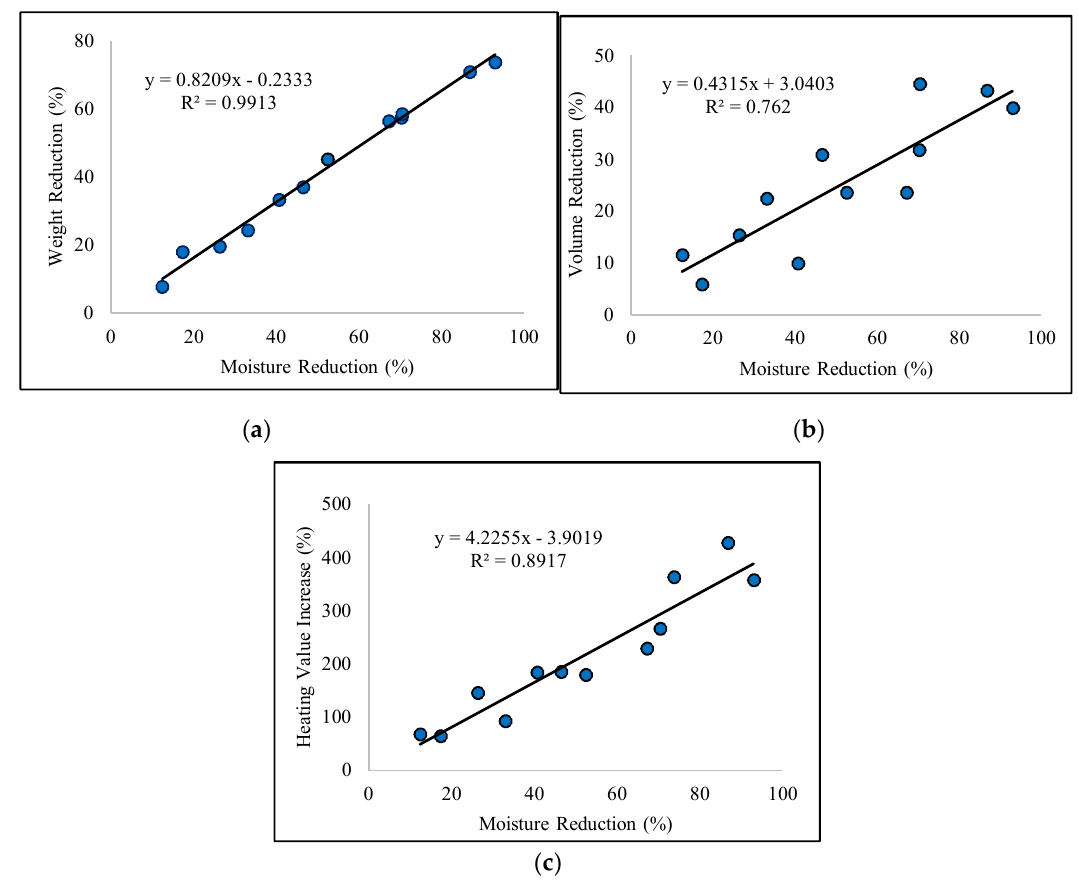
Figure 5. Effect of moisture reduction on ( a ) weight reduction, ( b ) volume reduction, and ( c ) heating value increase of the biodegradable waste samples.